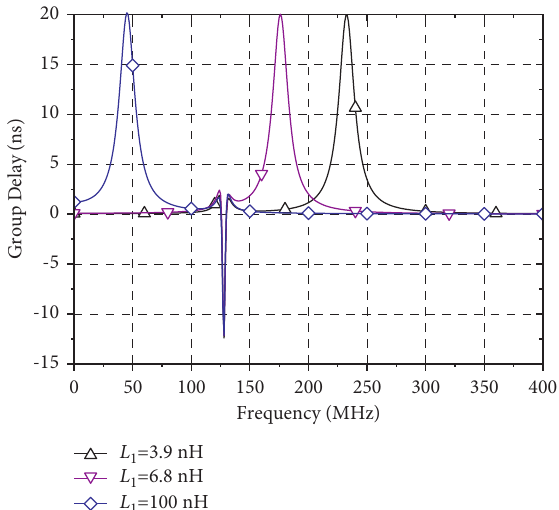
Figure 9: Negative delay of band pass in the band-stop filter with different L